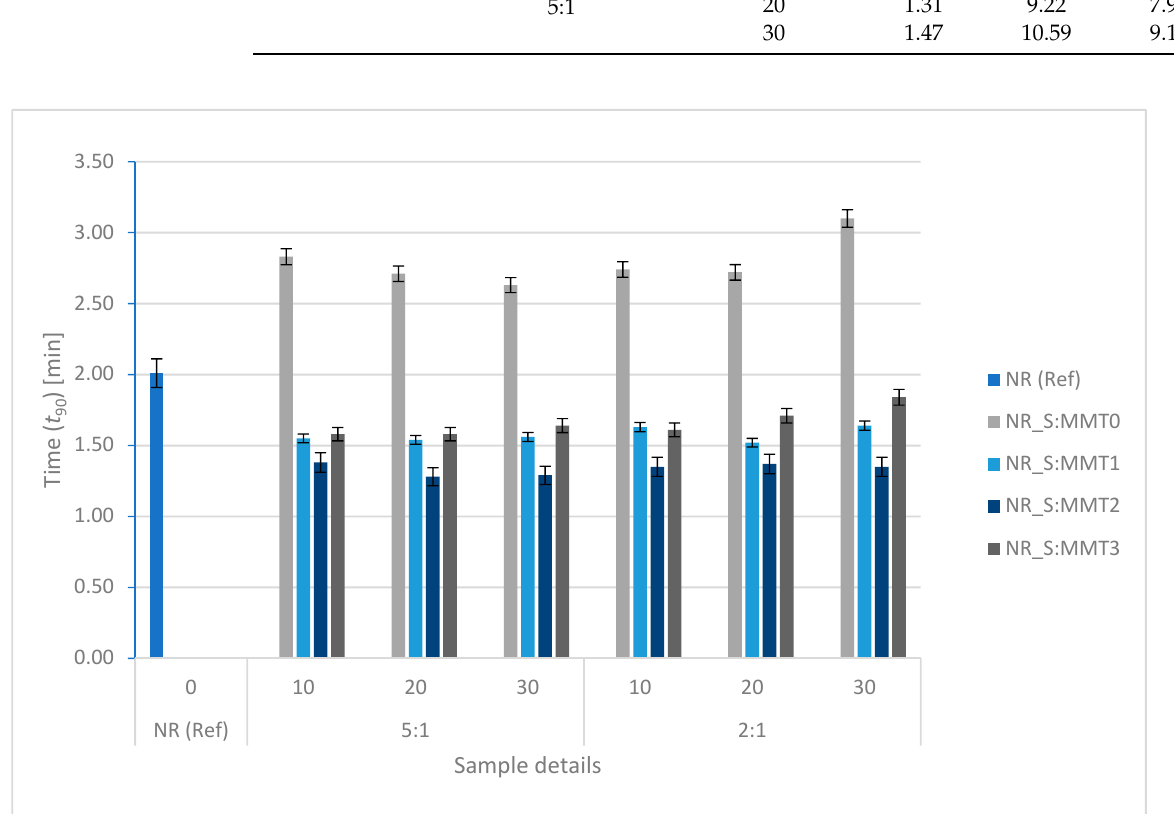
Figure 4. The optimum curing time ( t 90 ) for natural rubber composites.